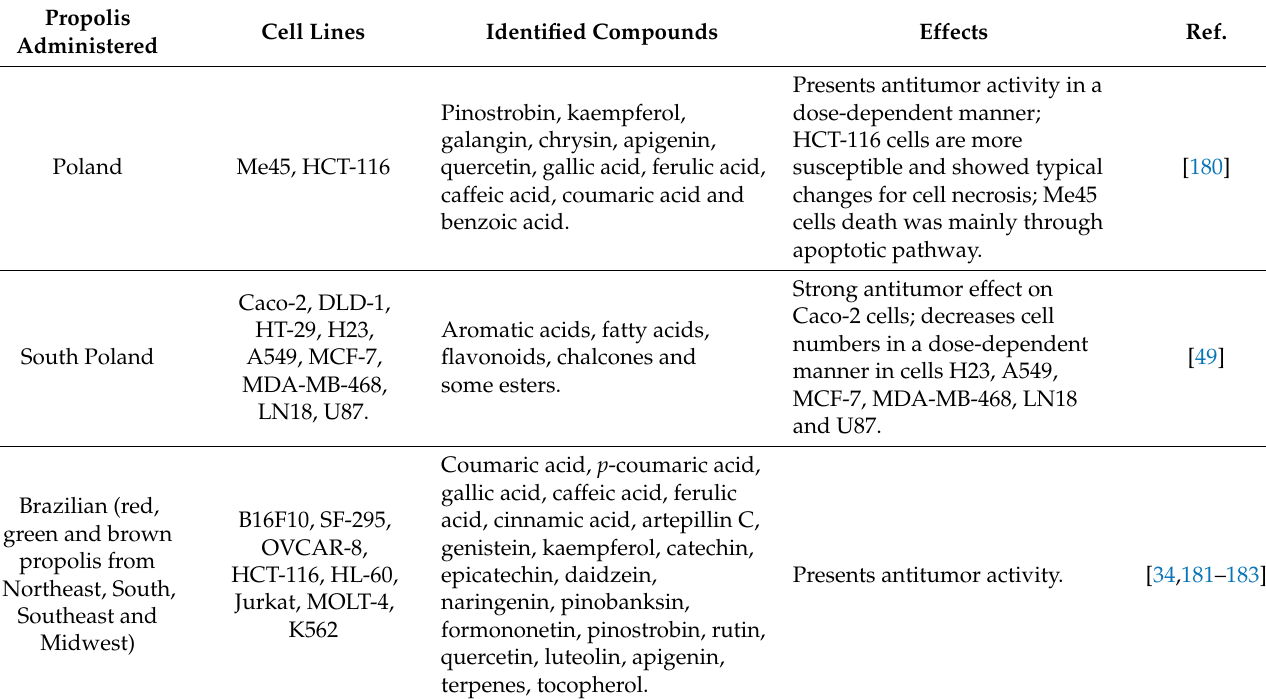
Table 7. Antitumor properties of propolis and identification of its chemical